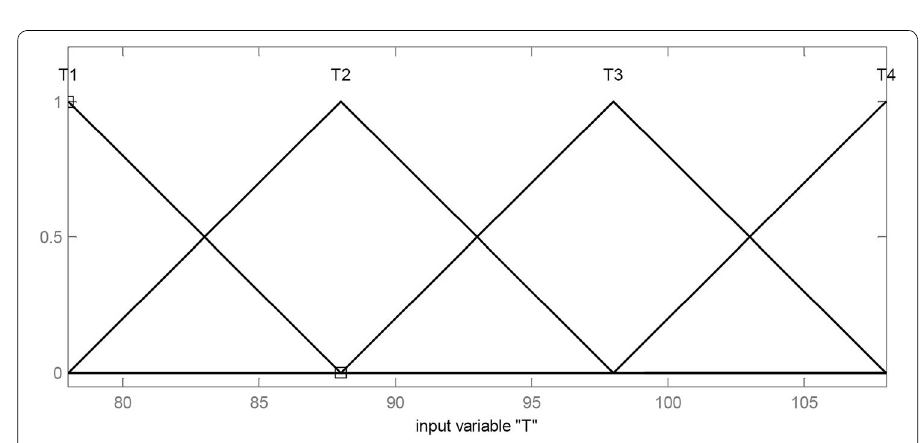
Fig. 3 Membership function of input variable “ T